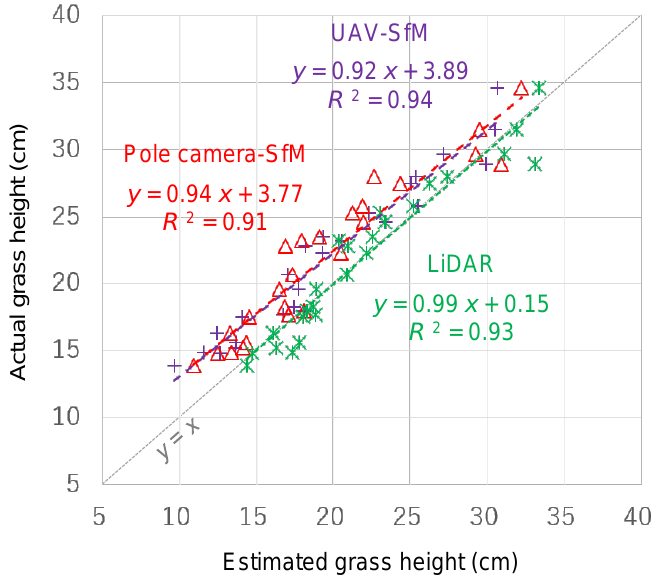
Figure 7. Comparing the grass height values estimated by SfM and LiDAR with the actual values measured by a ruler. The gray dashed line represents the 1:1 line for reference.